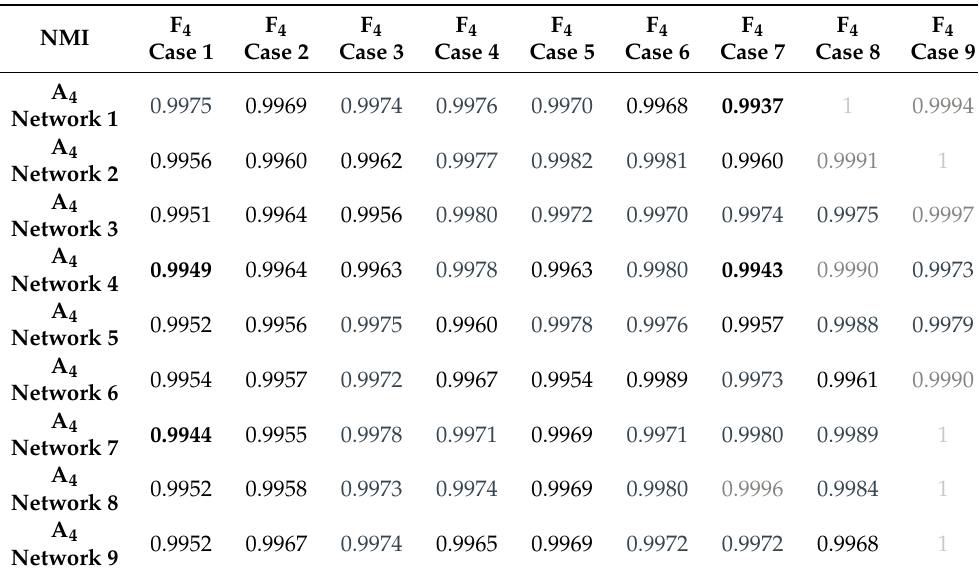
Figure 11. Benchmark graph. Model 4. Table 6. NMI. Model 4.